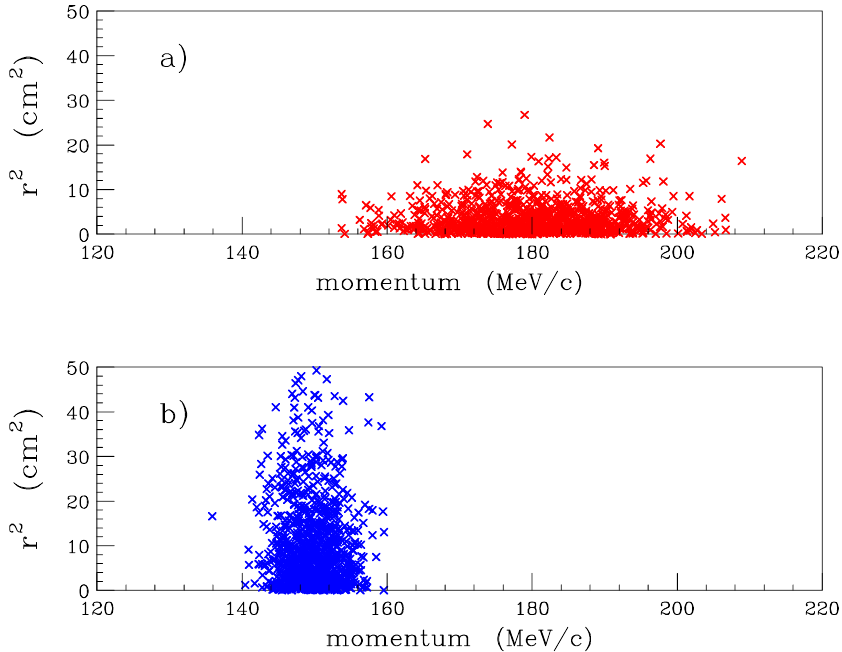
FIG. 33. (Color) Scatter plot of squared radii vs longitudinal momentum: (a) at the start and (b) at the end of the emittance exchange